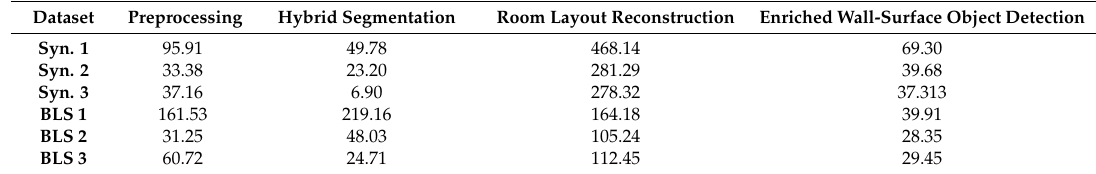
Table 6. Time cost (in seconds) for our proposed approach on the tested